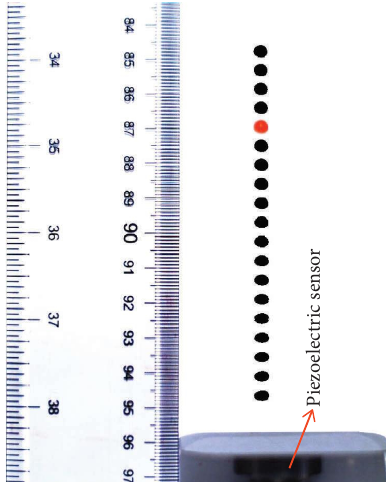
Figure 20: Overlay of raindrop photos taken by high-speed camera.